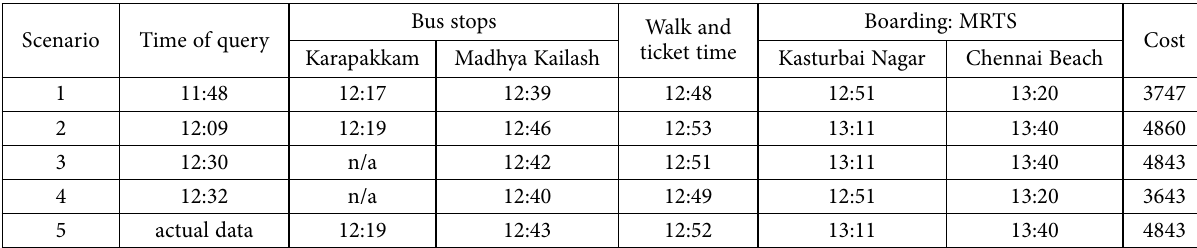
Table 1. ETAs at various times of query and the associated cost Bus stops Walk and Scenario Time of query ticket time